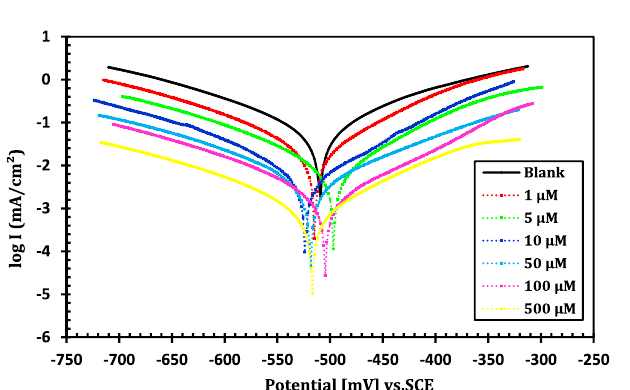
Figure 5. Potentiodynamic polarization curves of C-steel in 1 M HCl with different concentrations of inhibitor MA-1740 at 25